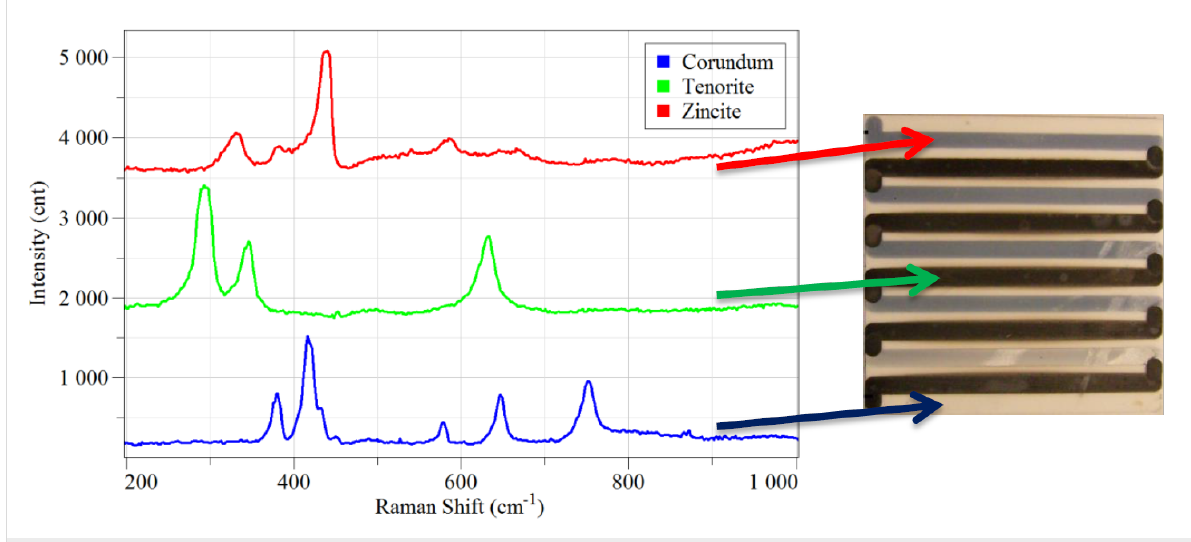
Figure 5: Raman spectra of the fabricated thermoelectric module for ZnO (red), CuO (green) and alumina substrate (in blue). Spectra shifted verti- cally and normalized for clarity purposes.